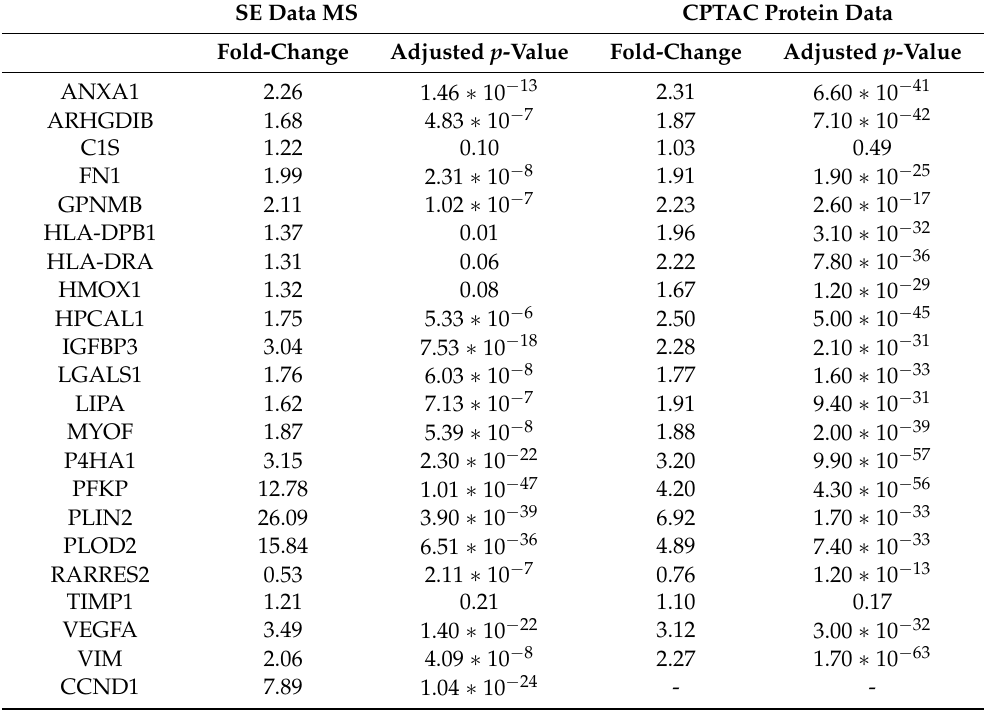
Table 3. Summary table of own MS data and CPTAC protein expression differences.